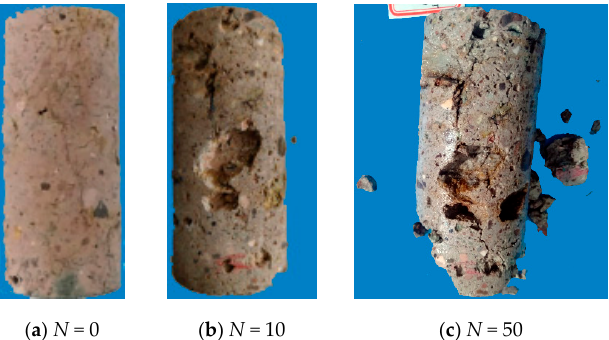
Figure 1. Apparent morphology of specimens under different freeze–thaw cycles. ( a ) Before freeze–thaw cycles, the surface of the specimen was covered with tiny spidery cracks due to the high ice content. ( b ) After 10 freeze–thaw cycles, the pits and fine pores on the specimen surface gradually increased and deepened, the deterioration degree of the specimen was aggravated progressively. ( c ) The exfoliation of the specimen gradually increased after 50 freeze-thaw cycles, and finally the lower part of the initial brown–red–white to the brown–black peat color.